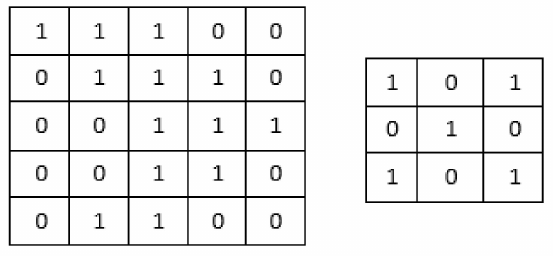
Figure 4. Input and filter image [8].